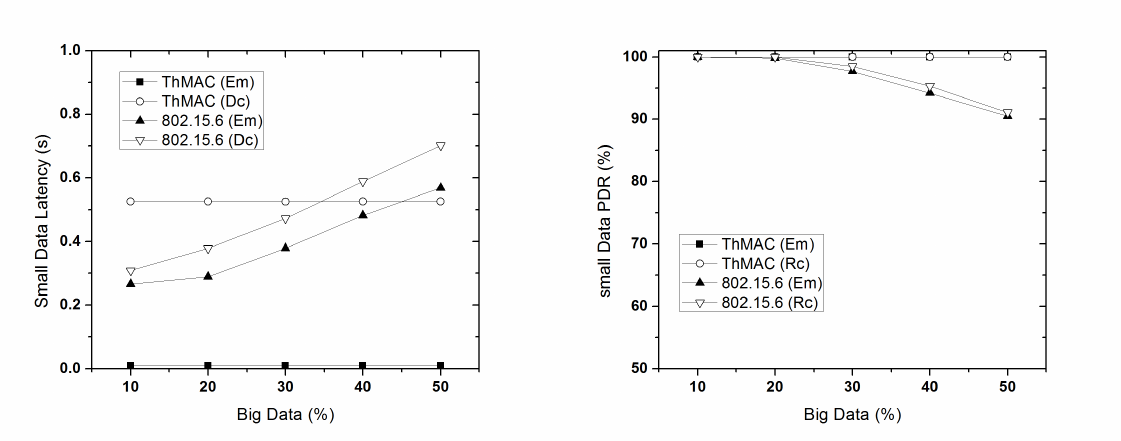
Figure 18. Impact of Big